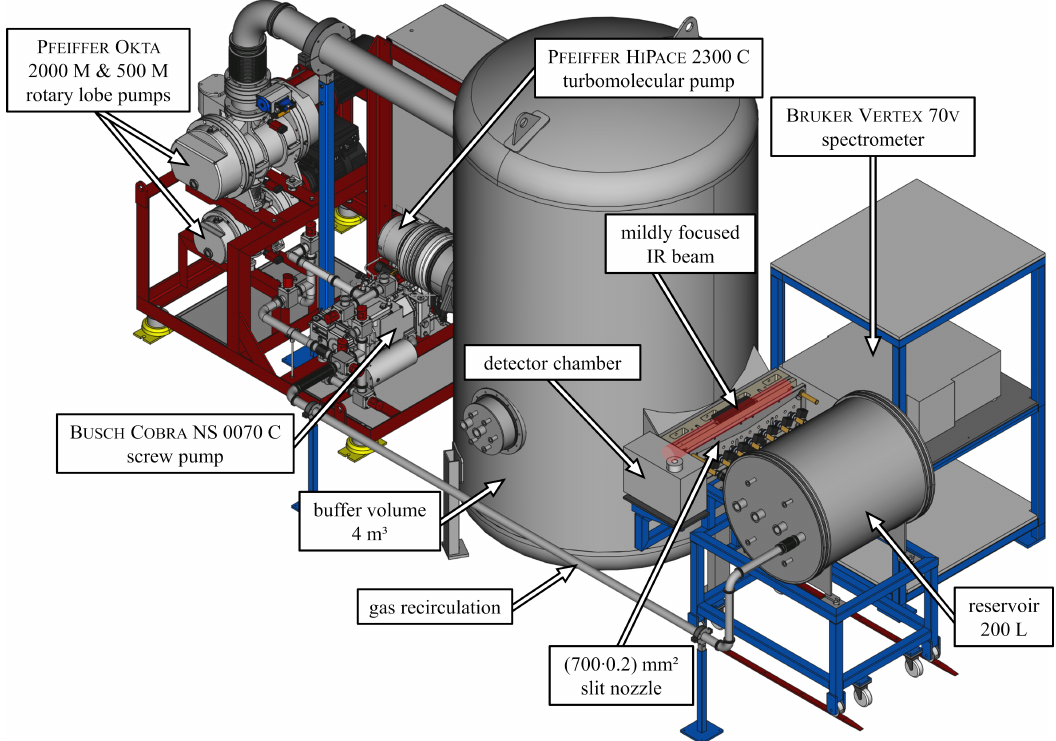
Figure 2. Overview of the gratin jet spectroscopy setup. Adapted from Ref. [85], licensed under CC BY